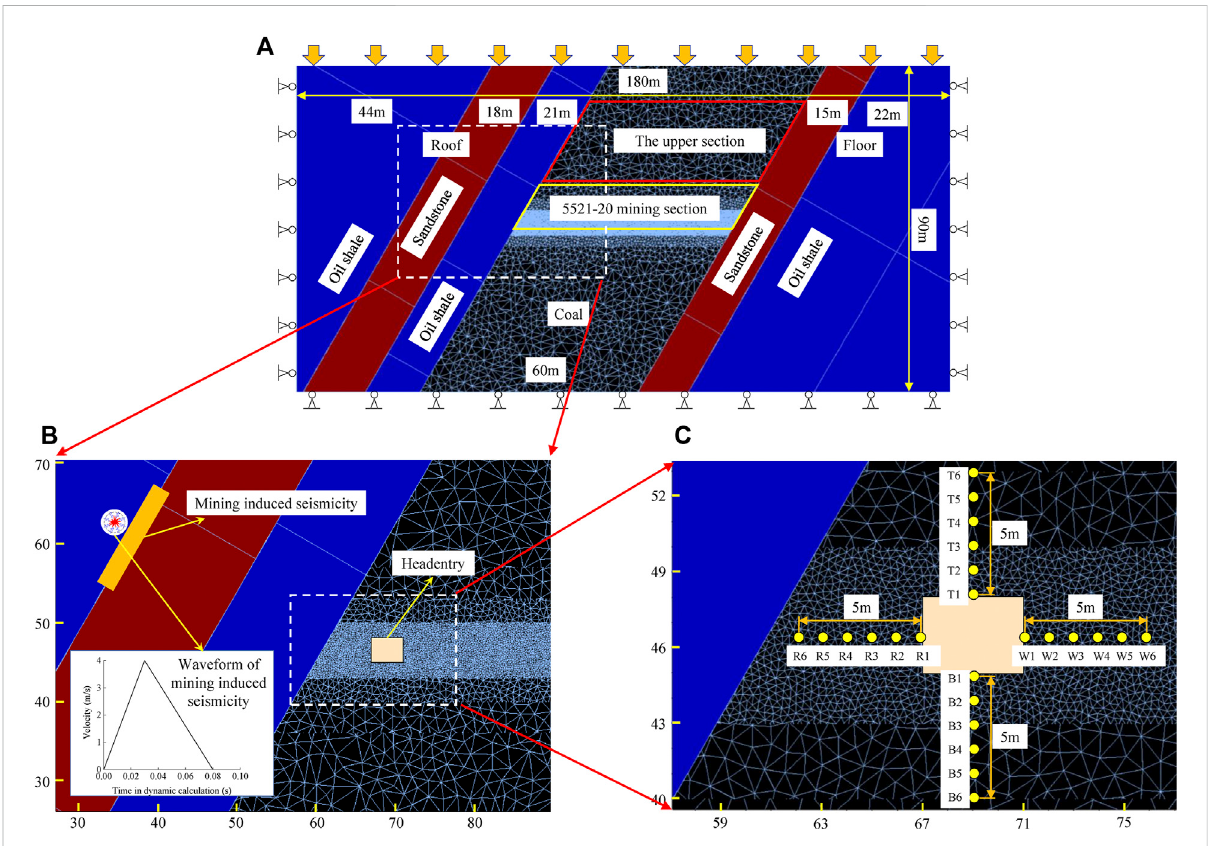
FIGURE 4 UDECnumericalmodel: (A) overviewofthemodel, (B) detailincl.hypocentreofmininginducedseismicity,and (C) detailof5,521 – 20headentry area (T, R, B, and W indicate the locations of